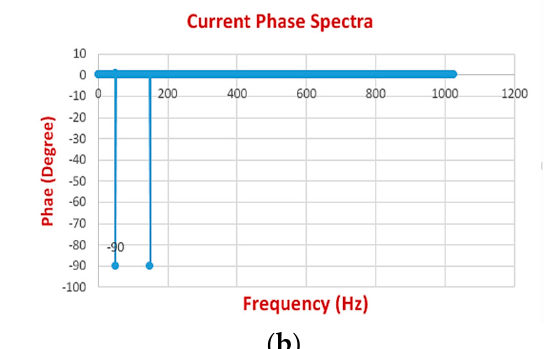
Figure 9. Spectra of current by the smart meter, ( a ) magnitude and ( b ) phase spectrum.